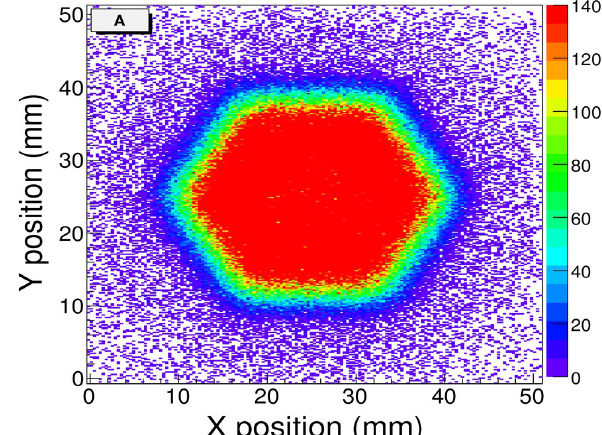
Fig. 7: Geometry of GEANT4 simulation of coincidence set-up of hexagonal BGO and LaBr (Ce)-PSPMT detectors. 3 The results compared with simulations are found to be in reasonable agreement in either case. The typical imaging performance is illustrated in Fig. 8. The position resolution, measured from the fit of the 1-d Y-projection of a slice of X- axis (22.5-27.5 mm) of the BGO image (Fig. 9), is 3.77(08)